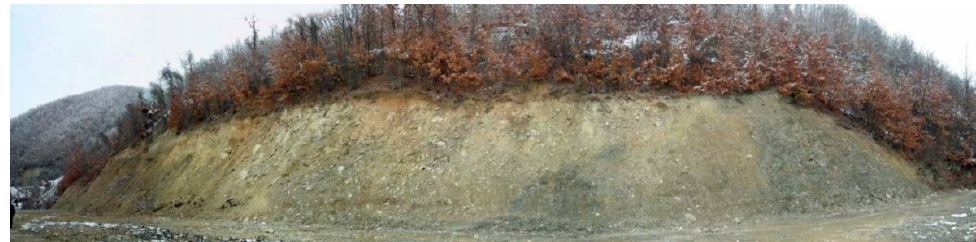
Figure 4. Locality “Jezgrovi ć e 2” which was formed in landslide [25].